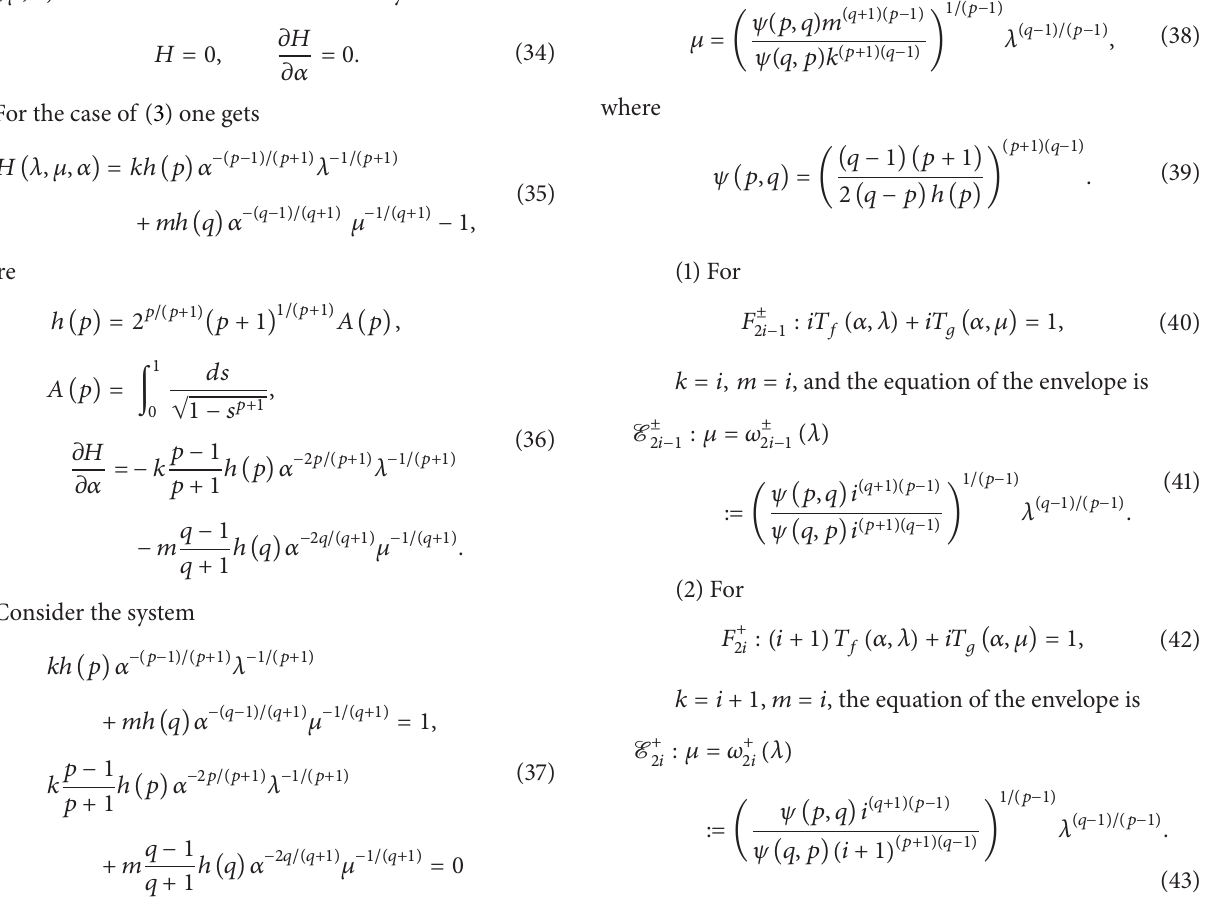
Treat 𝛼 as a parameter. The family of envelopes for 𝐻(𝜆, 𝜇, 𝛼) = 0 can be determined from the